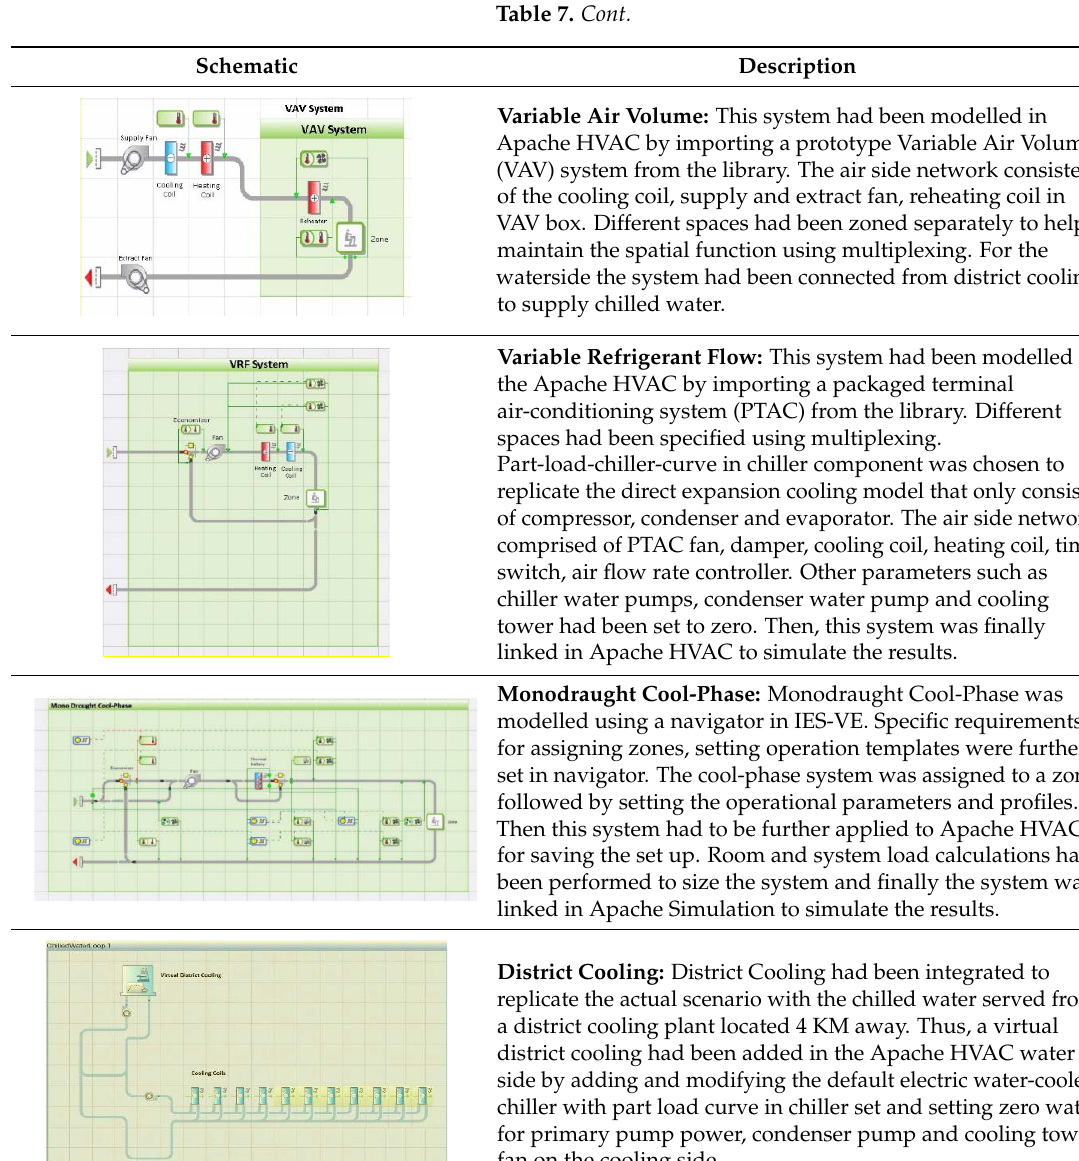
Table 8. Design variables for Baseline Fan Coil Unit (FCU).